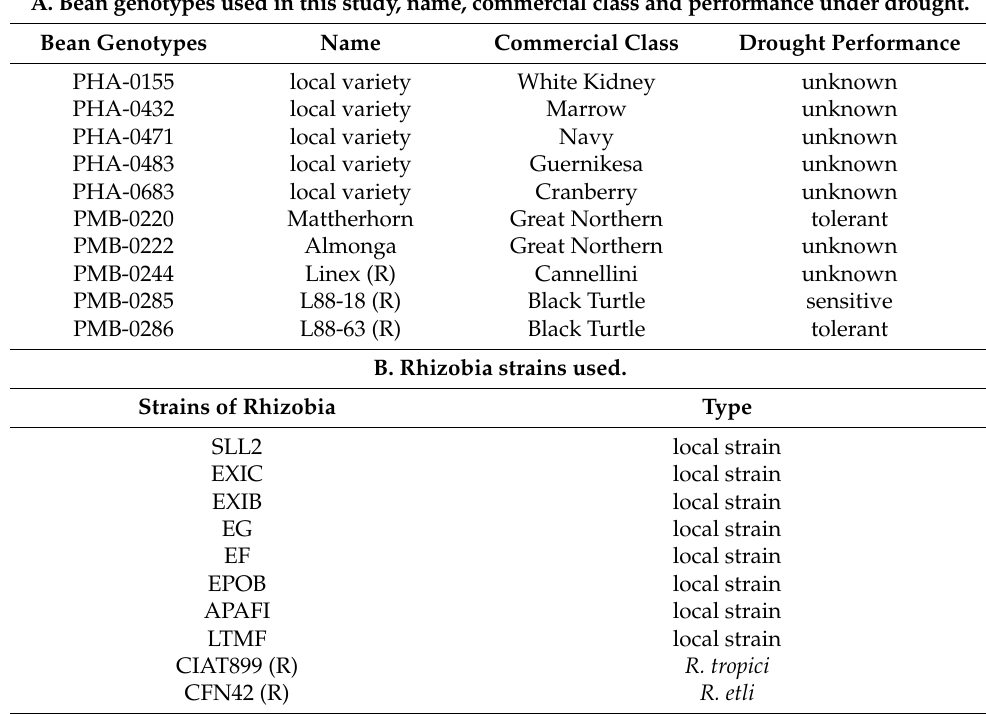
Figure 1. ( A ) Greenhouse experiment and ( B ) field experiment. Table 1. There were three genotypes of beans and two strains of rhizobia of reference (R). A. Bean genotypes used in this study, name, commercial class and performance under drought.